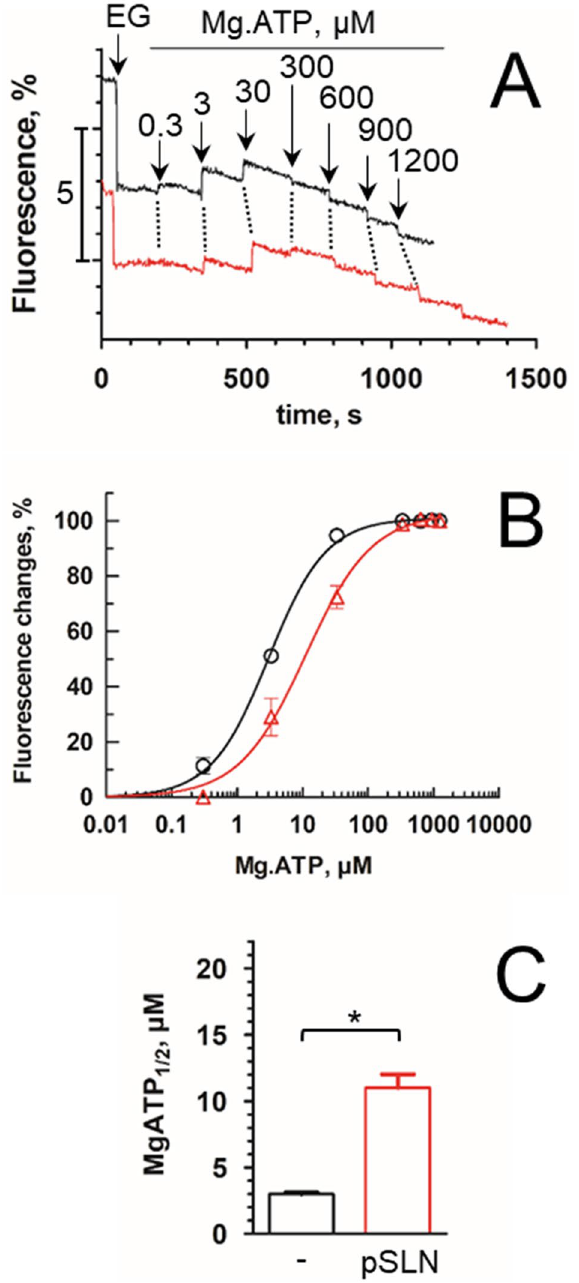
Figure 5. Effect of SLN on ATP binding. Binding of Mg.ATP as deduced from tryptophan fluorescence changes for recombinant SERCA1a alone (black) or supplemented with pSLN (red). ( A ) One representative series of experiments among three for each conditions are shown here. A first addition of 2 mM EGTA (EG) was done to reduce free Ca 2+ to about 4 nM. Increasing amounts of Mg.ATP were added from 0.3 to 1200 µM. Larger additions of 300 µM Mg-ATP (from 600 to 1200 µM) led to a decrease of the fluorescence. Such additions were done to estimate the inner filter effect due to nucleotide absorbance. Note that using 295 nm instead of a shorter excitation wavelength minimizes the inner-filter effect of the nucleotide. Traces were corrected for small dilution effect upon each addition but not for inner filter effect of nucleotide. ( B ) The changes in fluorescence were plotted as fractional values after normalization to 100% of the maximal change in fluorescence in each series (recS1a, black circles; recS1a + pSLN, red triangles). Each traces are the average of three independent experiments. Data were fitted with a “one-site specific binding law” with Hill slope. nH are 0.99 ± 0.04 and 0.95 ± 0.06, respectively, thus in agreement with a unique binding site. ( C ) Affinity for Mg.ATP as deduced from ( B ). Mg-ATP 1/2 are 3.00 ± 0.12 µM for recS1a and 11.0 ± 1 µM for recS1a + pSLN, with p =